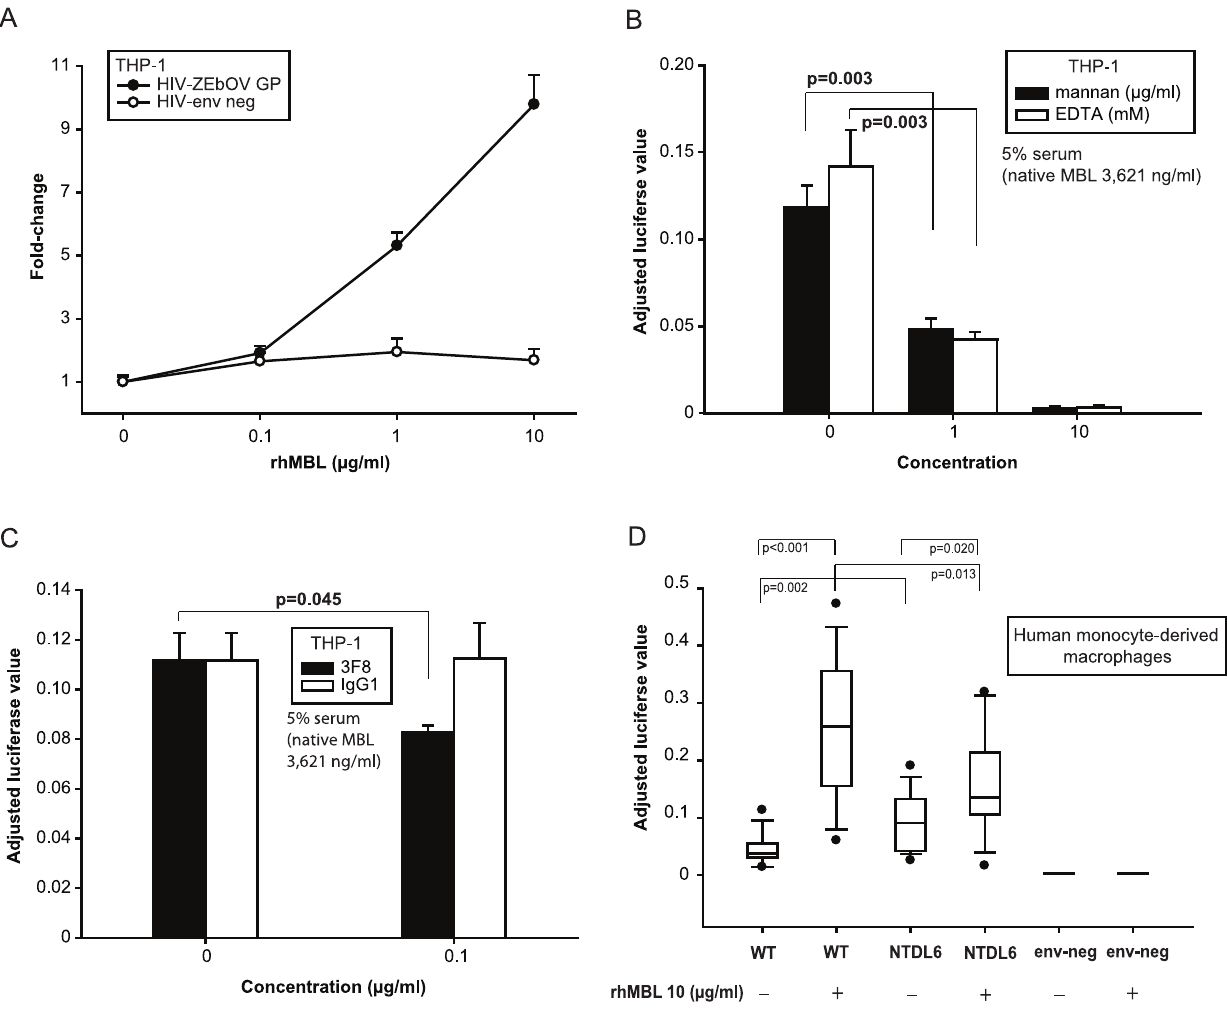
Figure 5. MBL enhances HIV-EBOV GP infection of THP-1 cells and human monocyte-derived macrophages. (A) We stimulated 5 6 10 4 THP-1 cells with PMA (10 ng/ml) and supplemented the cells with IL-4 (100 ng/ml) for 72 hours. We preincubated HIV-EBOV GP or HIV- env negative virion-like particles (1200 pg p24/100 m l) with or without rhMBL before infecting differentiated adherent THP-1 cells cultivated in 5% MBL-deficient serum. (B) We cultivated 2.5 6 10 5 PBMC derived from human single-donor buffy coat samples in RPMI-1640 with 10% FBS and stimulated the cells with M-CSF (50 ng/ml) to induce differentiation of monocyte-derived macrophages. We infected cells with HIV-EBOV GP (WT), HIV-EBOV- D GP NTDL6 (NTDL6, mutated GP lacks 217 amino acids in the heavily glycosylated mucin-rich region) or HIV- env negative (env neg) in the presence or absence of rhMBL. The box plot represents outliers (dots), 10 th and 90 th percentiles (whiskers), 25 th and 75 th percentiles (box) and median values (line). Significant differences in infection rates are shown. Luciferase values were adjusted for cell viability using alamarBlue (resazurin reduction assay) for all the above experiments, which were performed twice in quadruplicate.